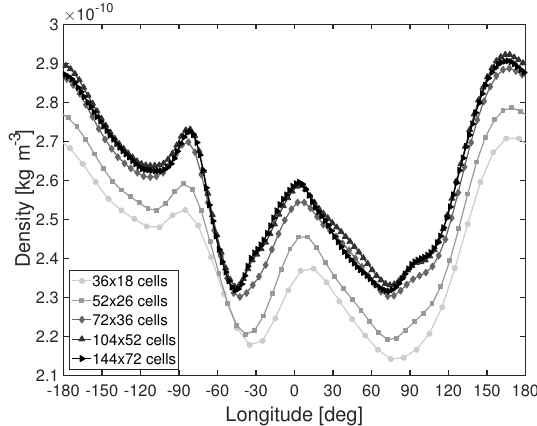
Figure 1. Grid sensitivity analysis at 0 ◦ latitude and 200km altitude (long × lat